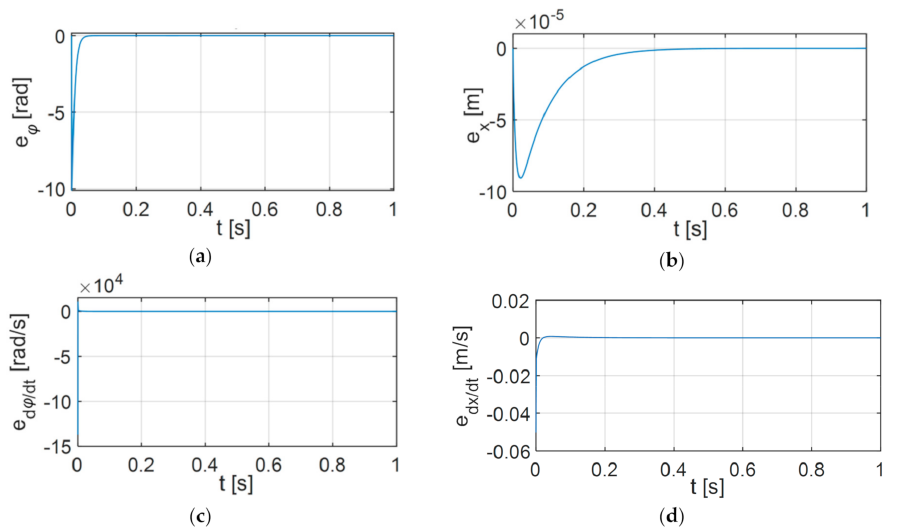
Figure 7. Follow-up movement errors: ( a ) position error of the active part e ϕ ; ( b ) position error of the passive part e x ; ( c ) speed error of the active part e d ϕ / dt ; ( d ) speed error of the passive part e dx / dt .